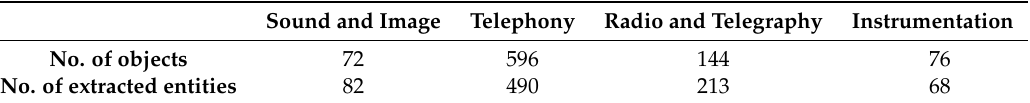
Table 1. Breakdown of museum objects into four categories and summary of entities extracted per category.